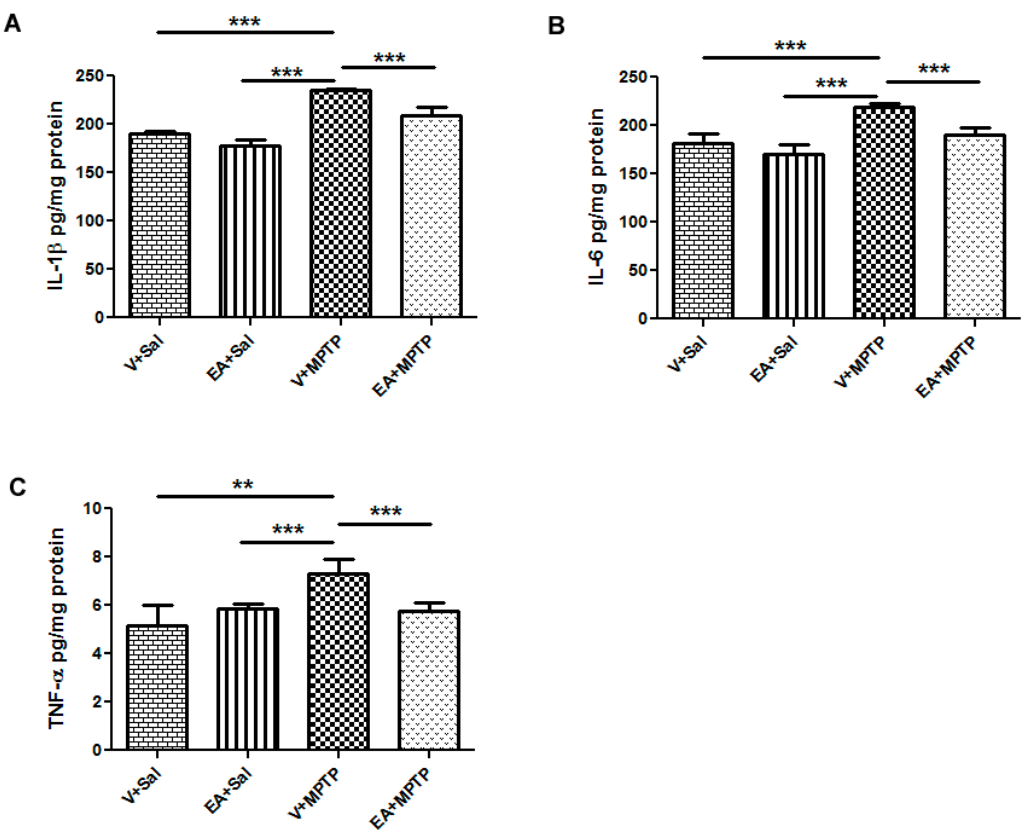
Figure 4. Determination of interleukin-1 β (IL-1 β ), IL-6, and tumor necrosis factor-alpha (TNF- α ) in the striatum tissue of different experimental groups animals using enzyme-linked immunosorbent assay (ELISA). MPTP treatment significantly increased the levels of IL-1 β , IL-6, and TNF- α . EA treatment prior to MPTP injections significantly reduced the level of IL-1 β ( A ), IL-6 ( B ), and TNF- α ( C ) when compared with MPTP-treated animals. Values are expressed as mean ± SEM ( n = 4–5). Significance is denoted as ** p < 0.01 and *** p < 0.001.